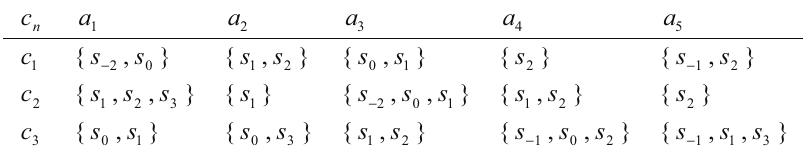
Table 7. Decision matrix of